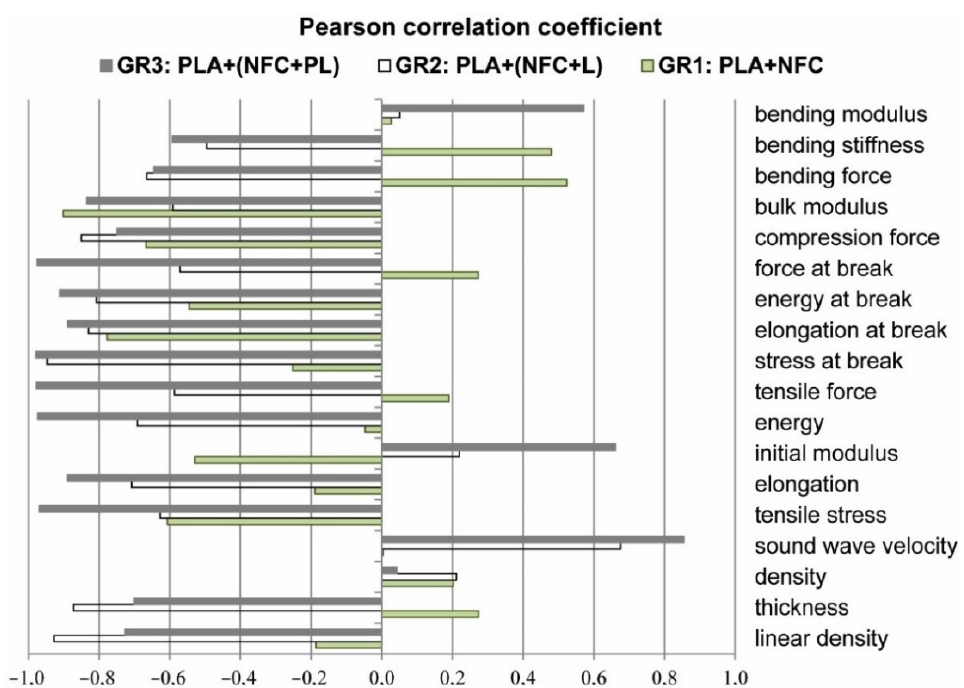
Figure 9. Pearson correlation coefficient between percentage of NCF and technical, structural, and mechanical properties of filaments—GR1: PLA + NCF; GR2: PLA + (NCF + L); GR3: PLA + (NCF + PL).